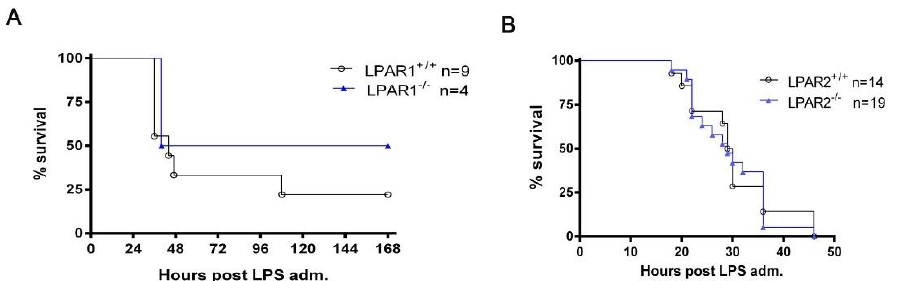
Figure 4. The ubiquitous genetic deletion of LPA receptor 1 or LPA receptor 2 does not significantly affect survival rates after LPS administration. Kaplan–Meier survival curves of LPAR1 − / − ( A ), LPAR2 − / − ( B ) and their appropriate littermate controls. Differences were tested with the Logrank test.